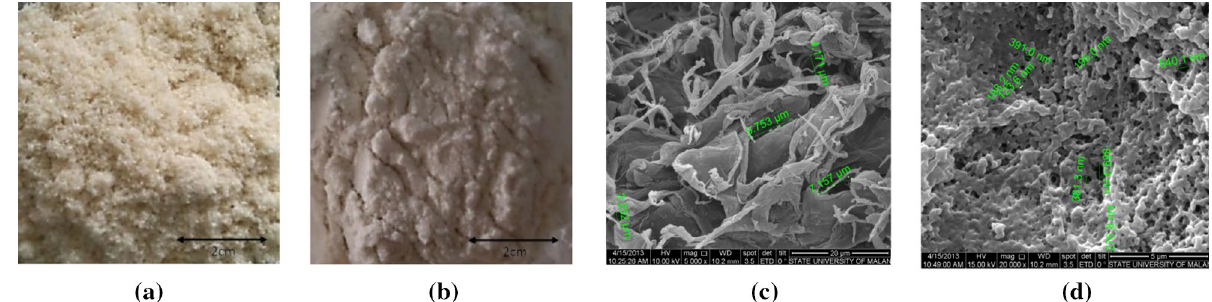
Figure 11. Cellulosic powder prepared from nata de coco ( a ), acetylated cellulose ( b ), SEM images of ( c ) nata cellulose (5000×), ( d ) acetylated cellulose